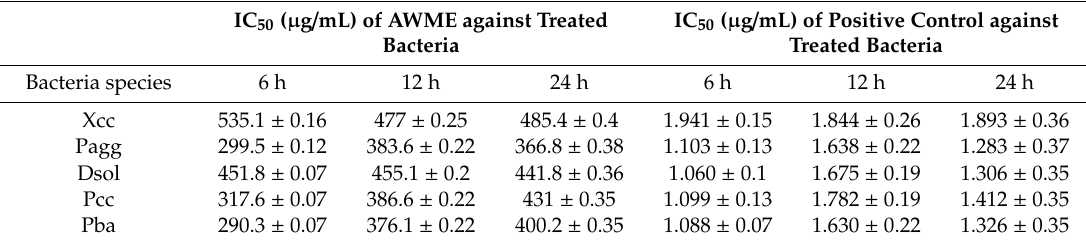
Table 3. IC 50 analysis for phytopathogens treated with AWME from fat vs. positive control (penicillin / streptomycin) for 6 h, 12 h, and 24 h. IC 50 ( µ g / mL) of AWME against Treated IC 50 ( µ g / mL) of Positive Control against Bacteria Treated